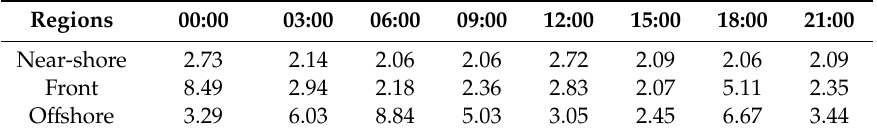
Table 4. Mixed layer depth (m) at each measurement time within 24-h in three